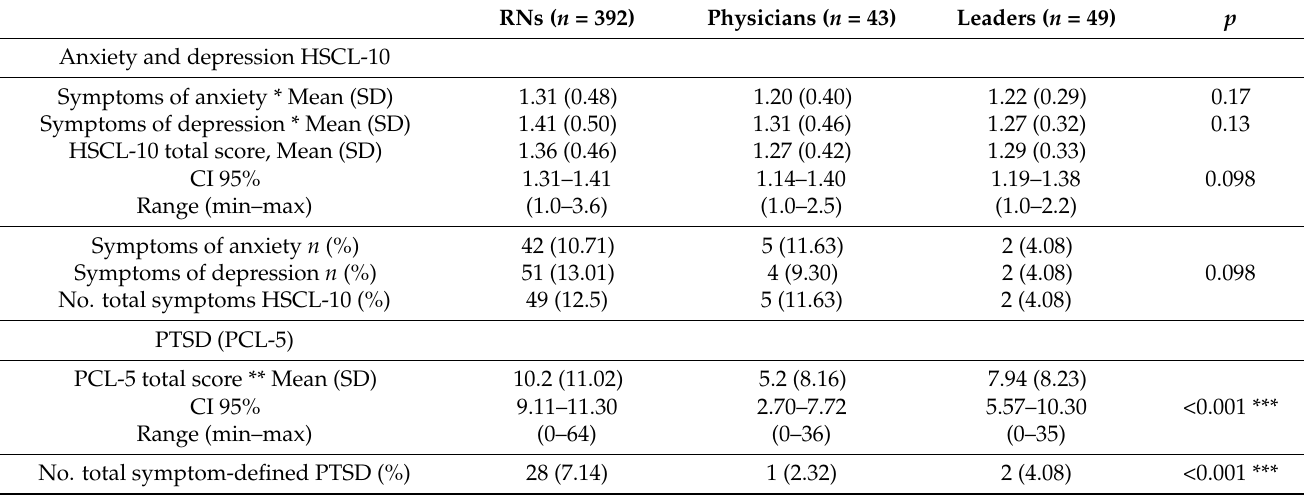
Table 2. Symptoms of anxiety and depression in health care professionals using the Hopkins Symp- tom Checklist-10 (HSCL-10) during the past week and symptom-defined PTSD (PCL-5) during the past month (N = 484).